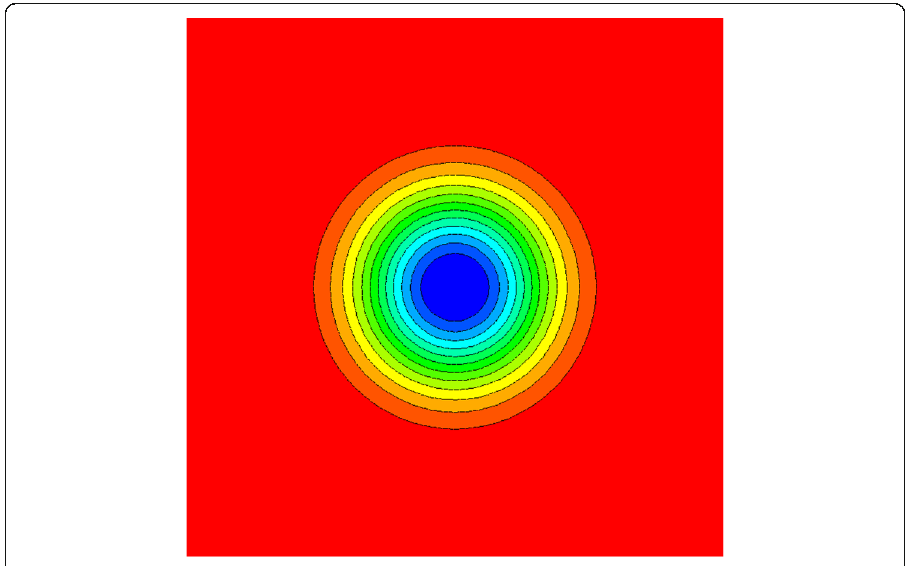
Fig. 12 Density contour of a 2D inviscid isentropic